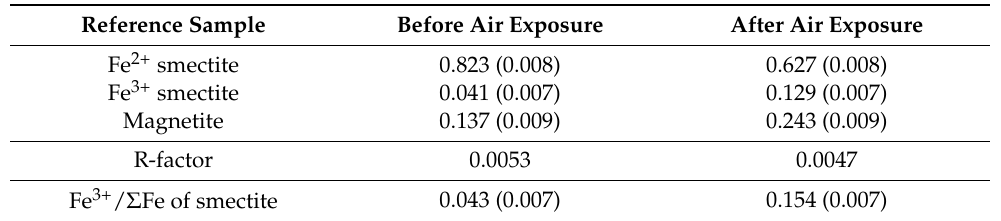
Table 2. Results of linear combination fitting of the Fe L-edge XANES spectra of the bulk powder of synthesized ferrous saponite collected before and after air exposure for 11 h. The calculated R-factor and the oxidation states of Fe (Fe 3+ / Σ Fe) in smectite are also shown. The Fe 3+ / Σ Fe values in smectite were calculated in molar ratios based on those of the reference samples. The values in parentheses represent errors in the